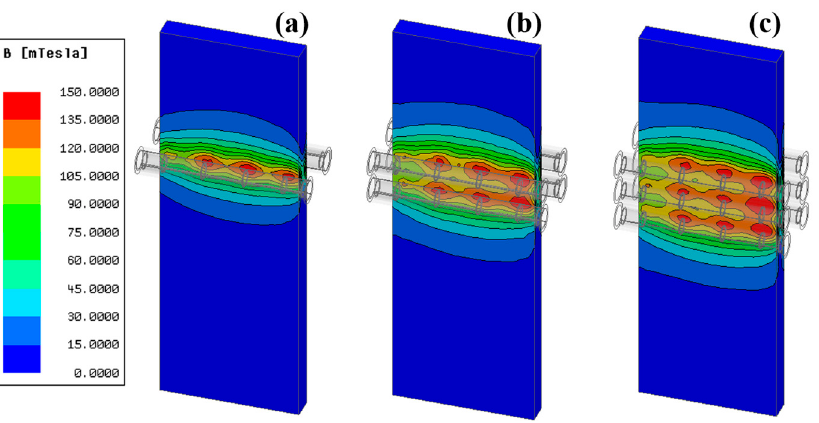
Figure 6. Contour of magnetic flux density on the surface of the stand with ( a ) one pair, ( b ) two pairs, and ( c ) three pairs of rollers.